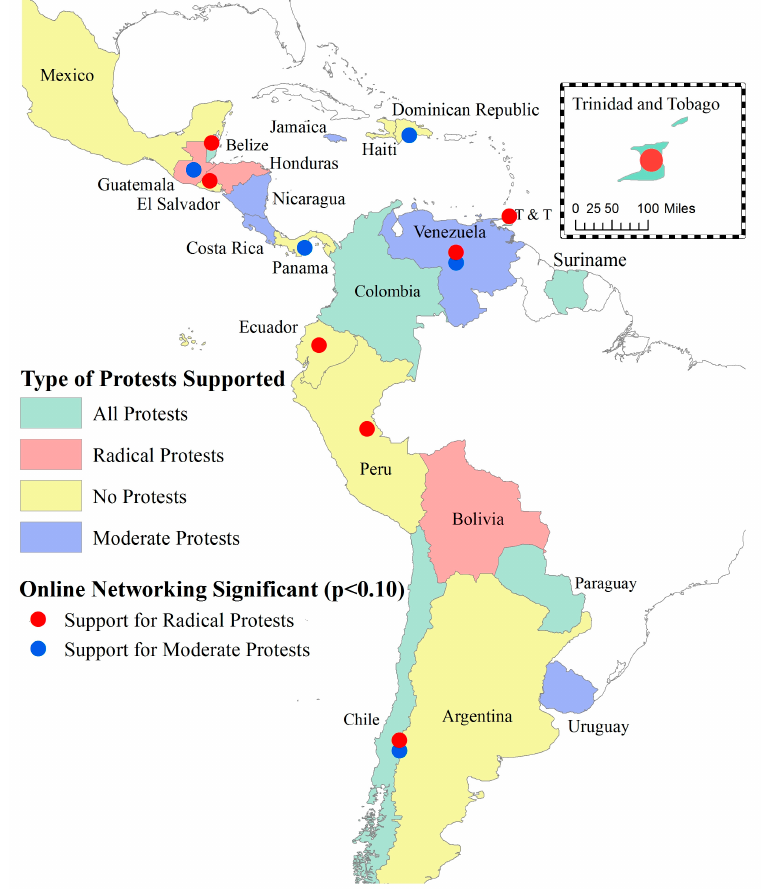
Figure 2. Type of protests supported and online networking.